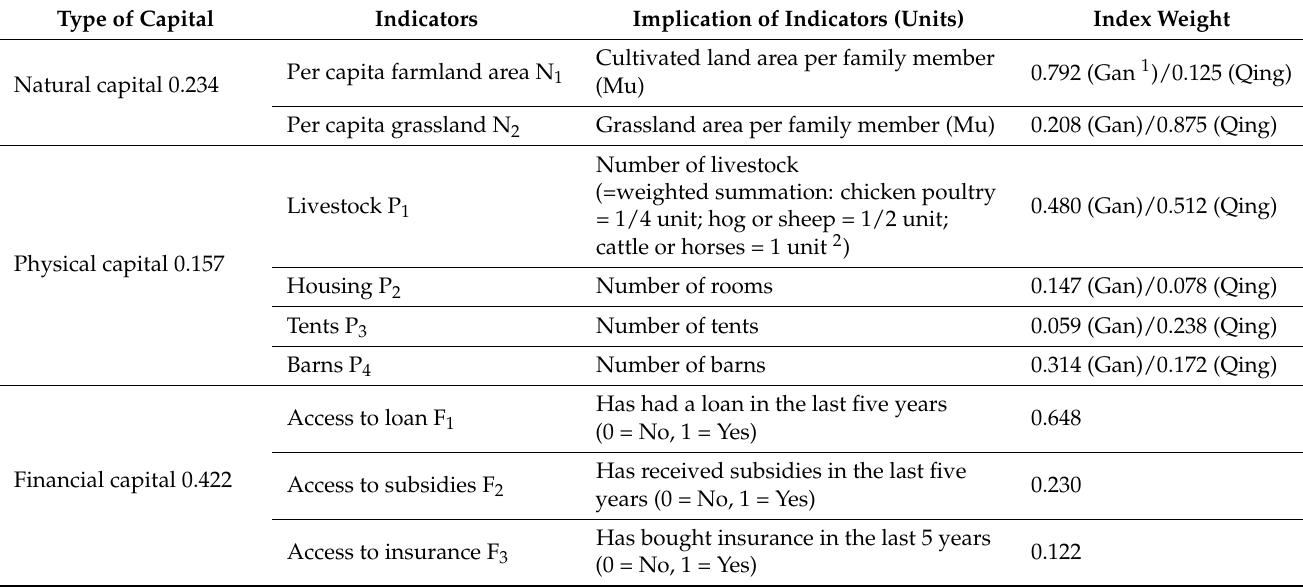
Table 1. Livelihood capital measurement index